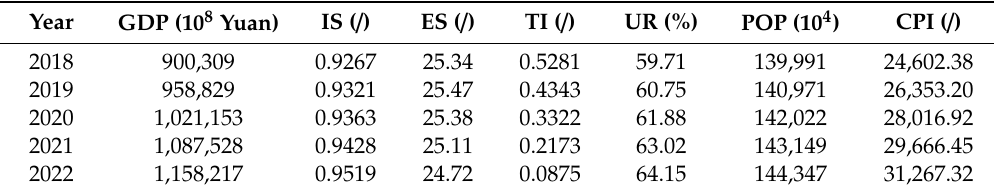
Table 7. Prediction results of each input variable under